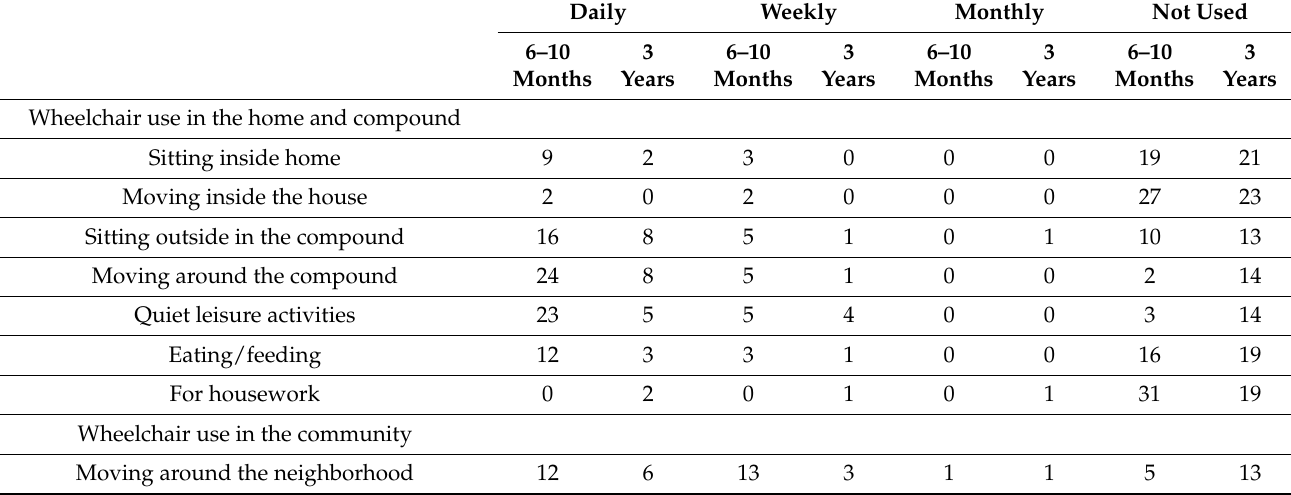
Table 4. Number of children using the wheelchairs for different purpose after 6 months N = 31 and 3 years N = 23 at home, in the compound (the close area around the houses), and in the